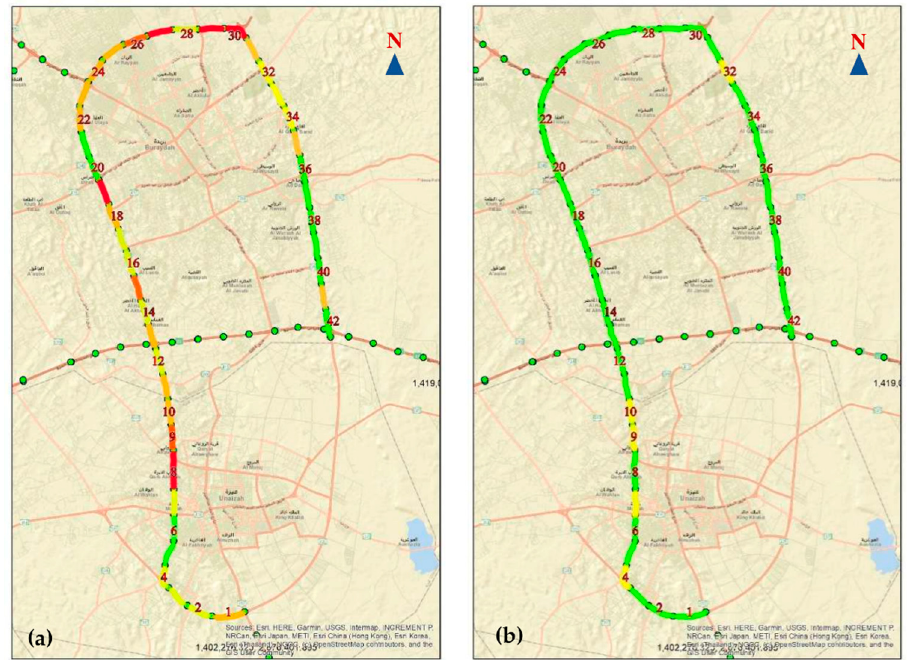
Figure 6. Risk assessment results showing hot spots on Buraydah Ring Road: ( a ) before installation of speed cameras, ( b ) after installation of speed cameras. of speed cameras, ( b ) after installation of speed